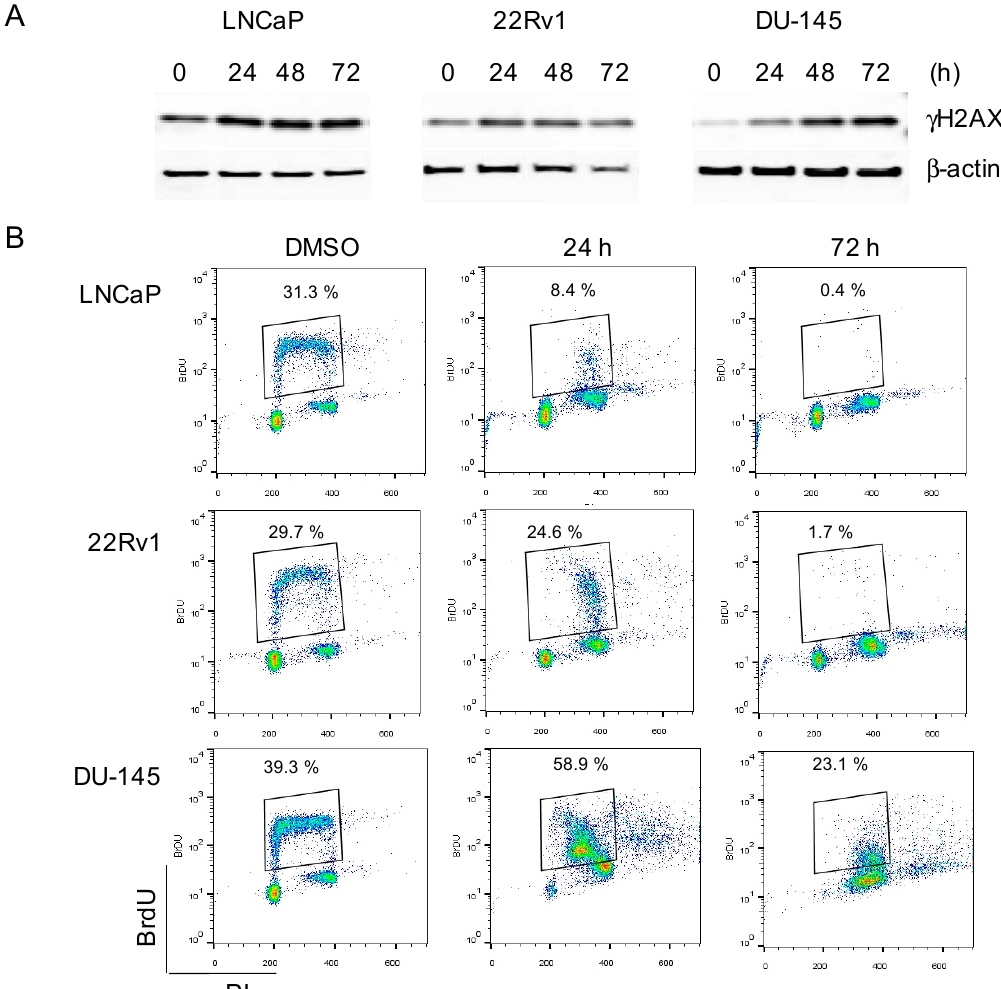
Figure 5. C-1311 induces DNA damage and decreases the percentage of replicating PCa cells irrespectively of AR status. ( A ) PCa cells were treated with 1 µ M C-1311 for the times indicated. Western blotting was carried for γ H2AX. β -actin was used as the loading control, n = 3. ( B ) Flow cytometry analysis of the BrdU incorporation (DNA synthesis) in PCa cells treated with C-1311 as in ( A ). Boxed region on the dot plots represents the BrdU-positive cells. Results are representative of three independent experiments and are presented as FloJo dot-plot graphs, which heat maps fluorescence intensities of greatest frequency in red.